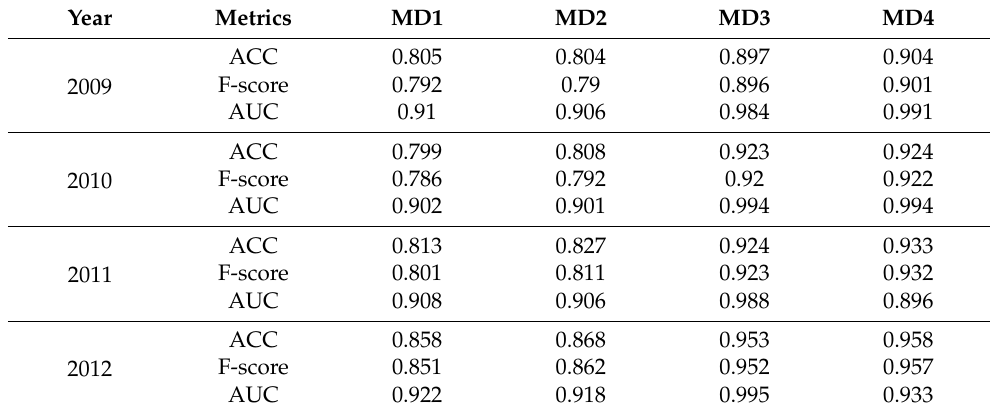
Table 7. The evaluation of the credit-scoring models for the different sample